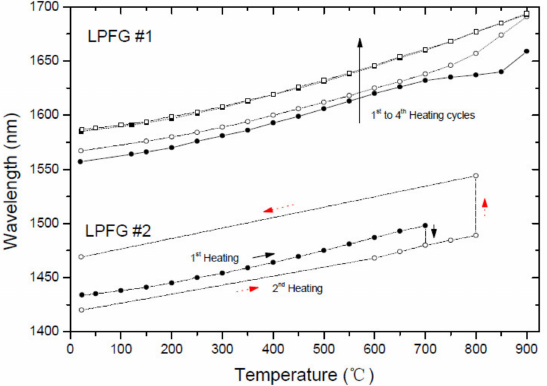
Figure 5. Thermal behavior of LPFGs submitted to several heating cycles. Adapted with permission from ref. [85]. © 2021 Taylor and